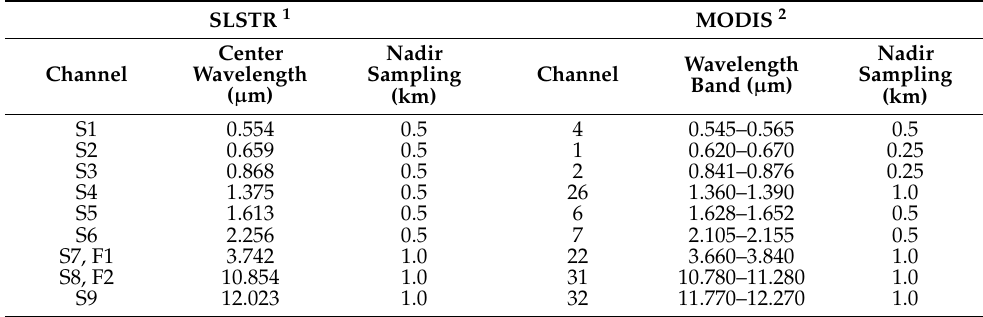
Figure 5. SLSTR covers the Earth with a near nadir-looking swath and an oblique swath as shown (figure is taken from the Sentinel-3 SLSTR User Guide [49]). Table 1. Spectral matches are generally quite close between SLSTR and MODIS. Two SLSTR channels have fi re-optimized versions indicated by band designations “F1” and “F2”.